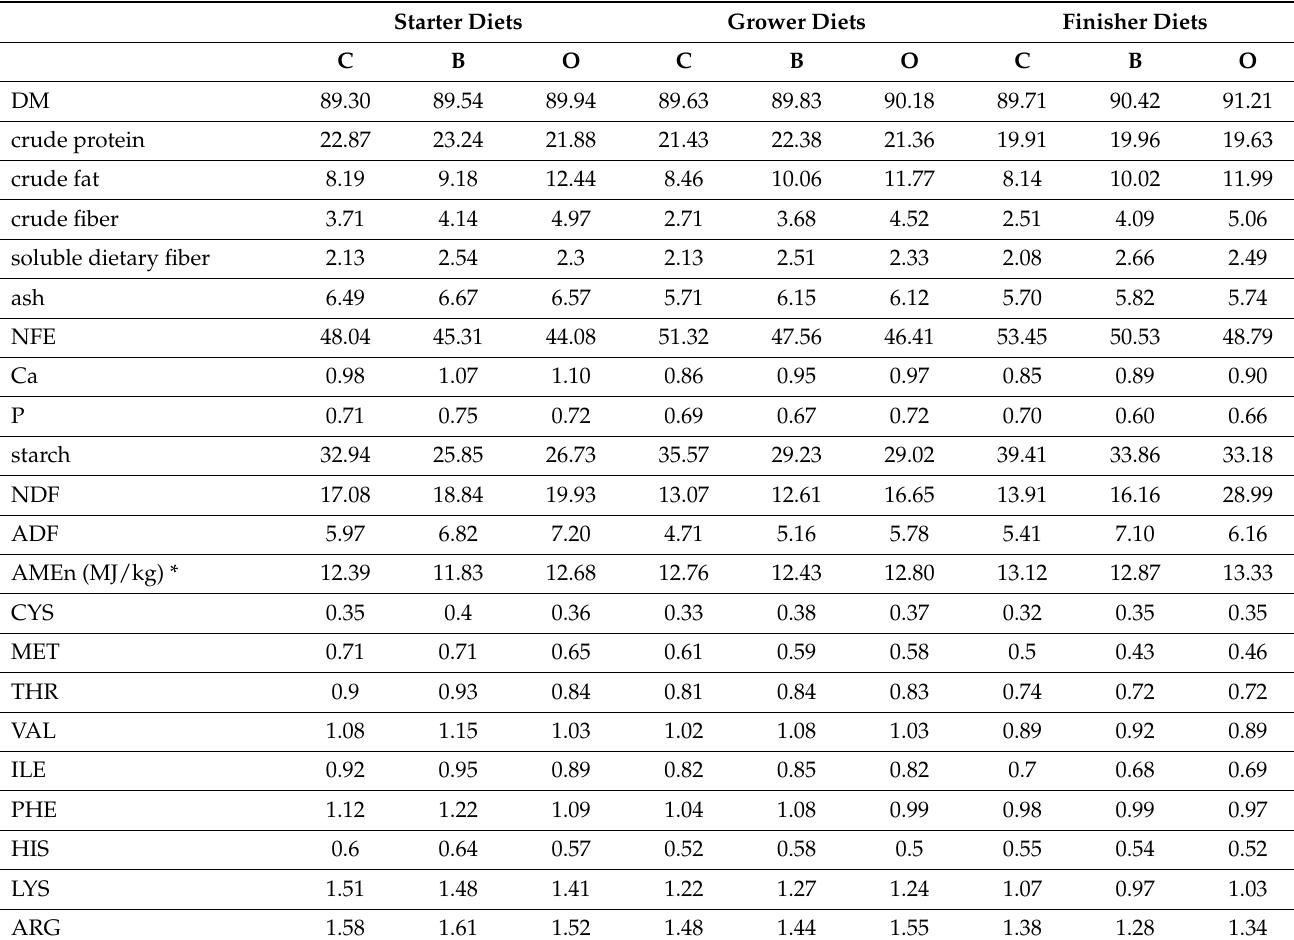
Table 3. The measured nutrient content of experimental diets